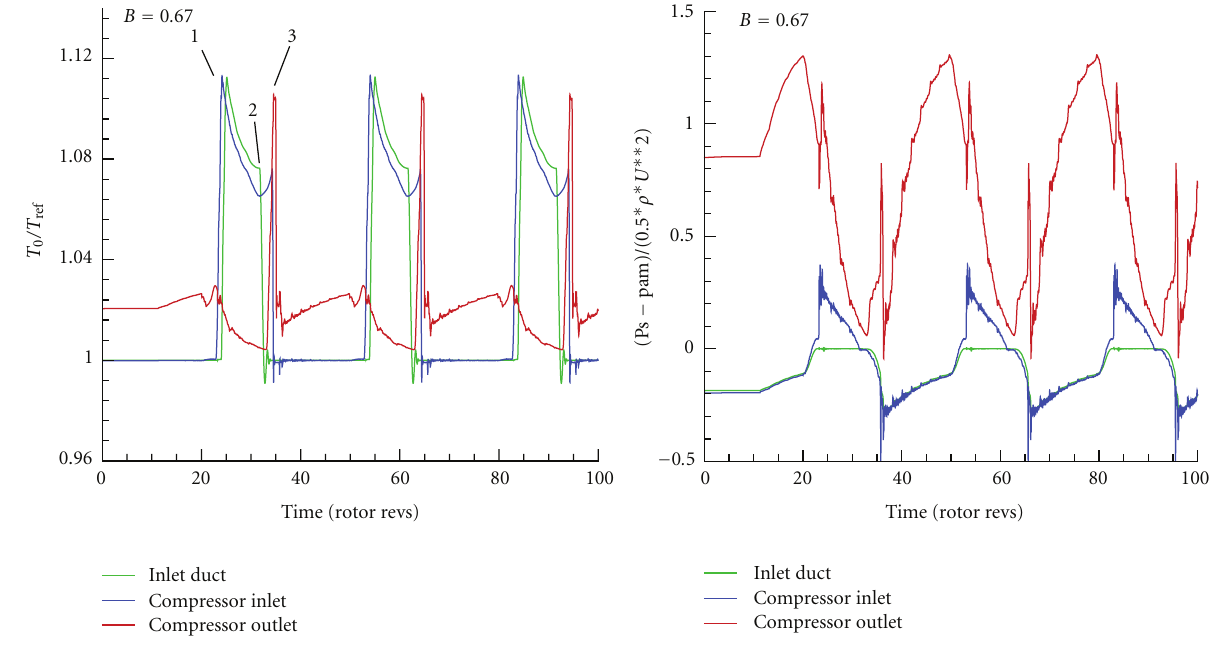
Figure 9: Numerical total temperature and total pressure at di ff erent locations.